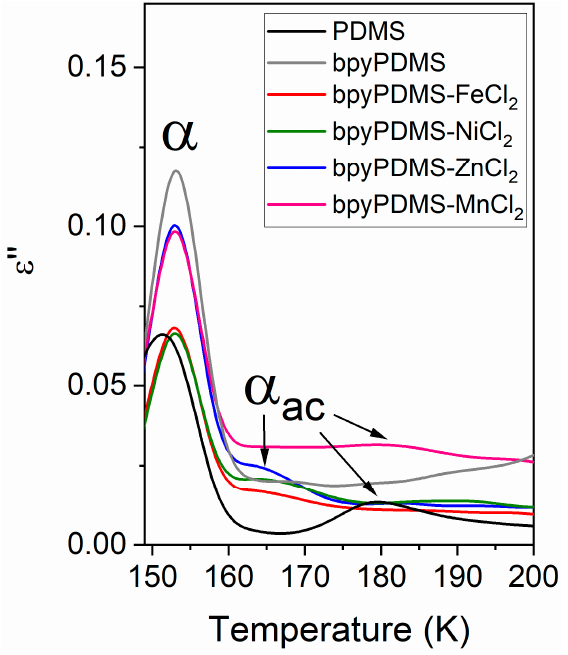
(cid:48)(cid:48) vs. temperature at frequency 1.15 Figure 6. Dielectric loss ε ” vs. temperature at frequency 1.15 Hz. Figure 6. Dielectric loss ε